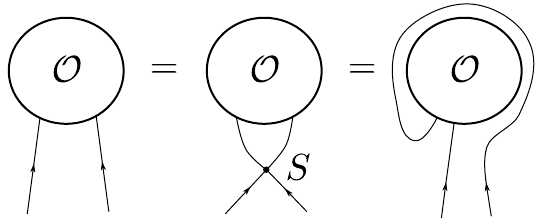
Figure 3. Graphical representation of the monodromy